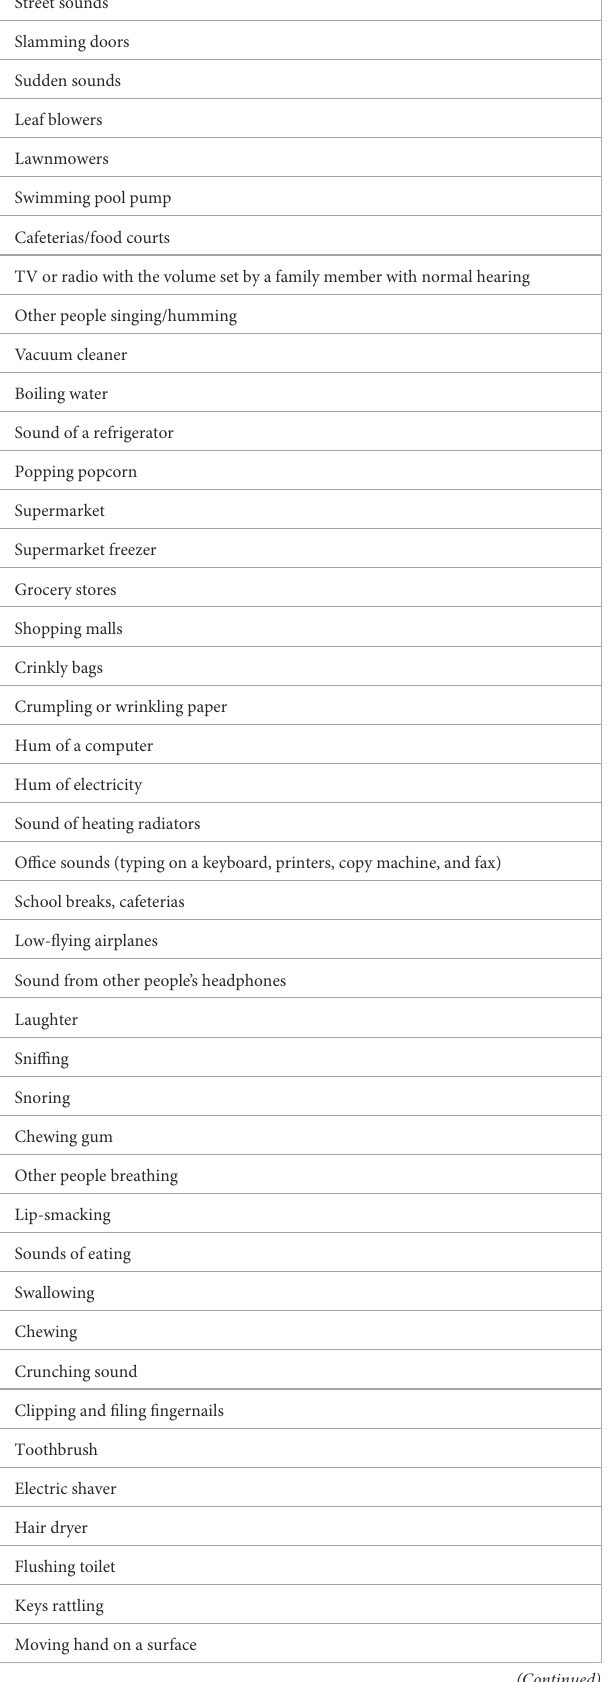
TABLE 1 Sounds reported by our patients as evoking negative